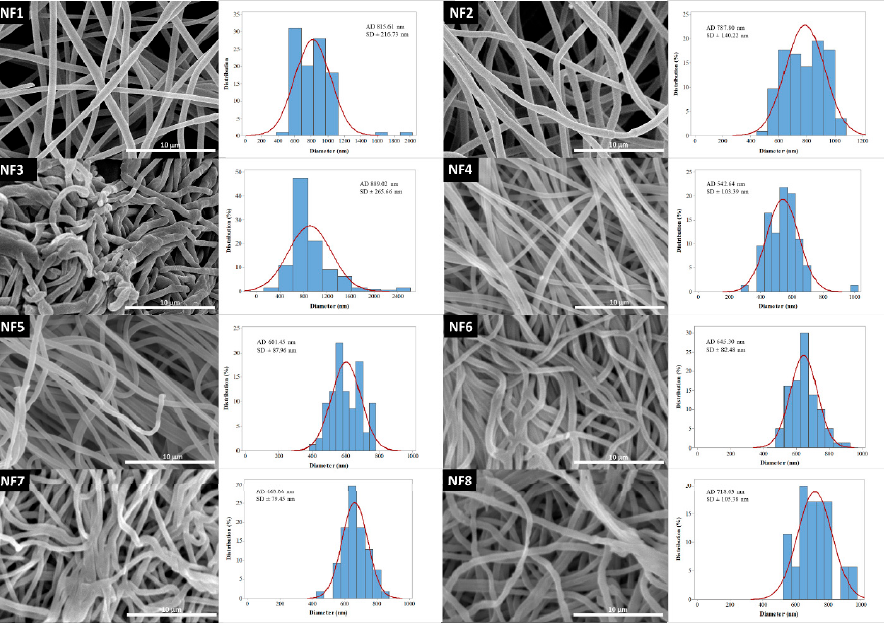
Figure 2. SEM images and diameter distributions of nanofibrous samples (5000× magnification).